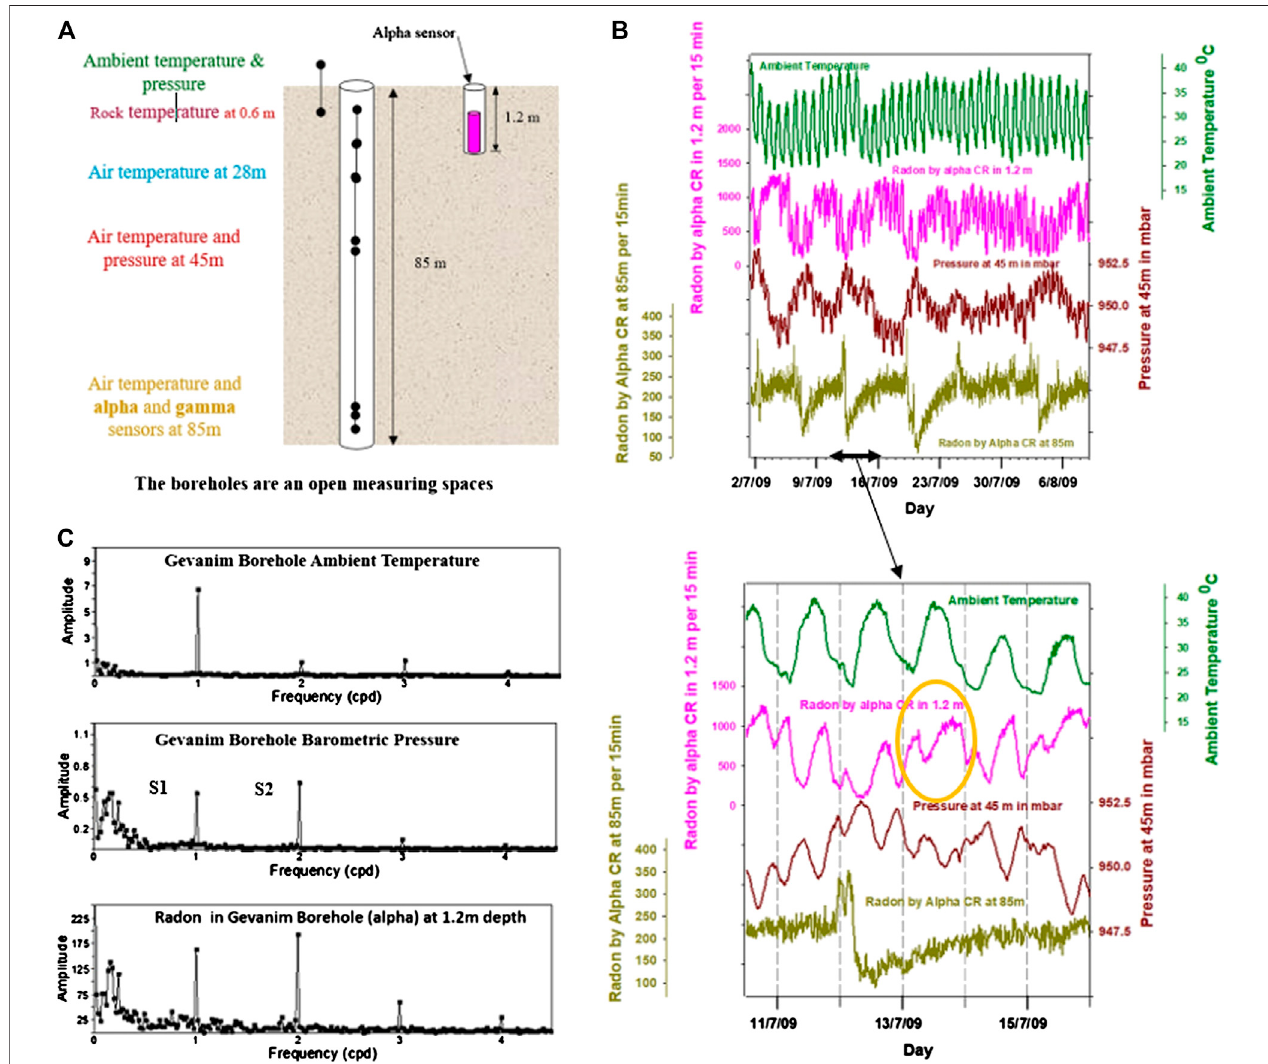
FIGURE 7 | (A) The radon setup in Makhtesh Ramon at Gevanim valley including alpha detectors at 1.2 and 85 m. (B) Radon time series as measured by alpha detectorsintheboreholesairspacenearthesurfaceat1.2 mdepthandatdepthof85 m. (C) TheFFTamplitude spectrumoftheambientpressureand radontemporal concentration changes at the Gevanim Valley, as measured by alpha counting at 1.2 m